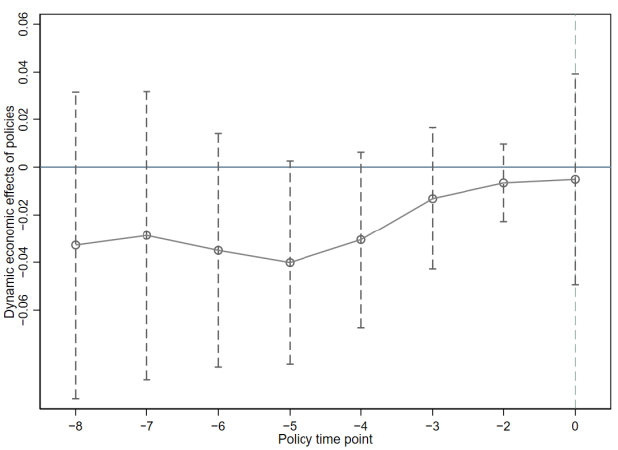
Figure 2. Parallel trend test for real GDP.